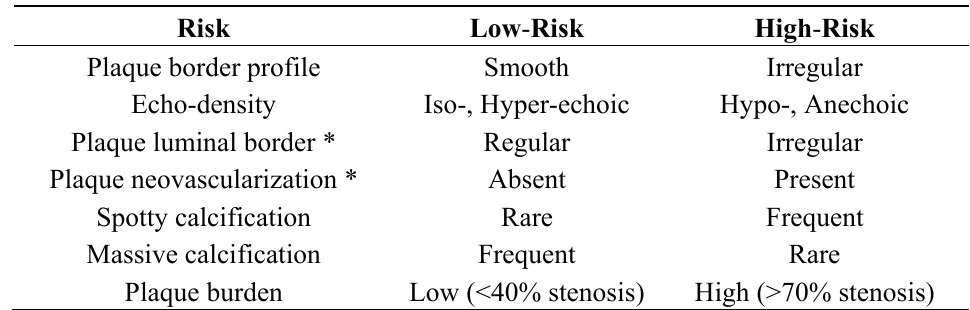
Table 4. Ultrasound appearance and plaque